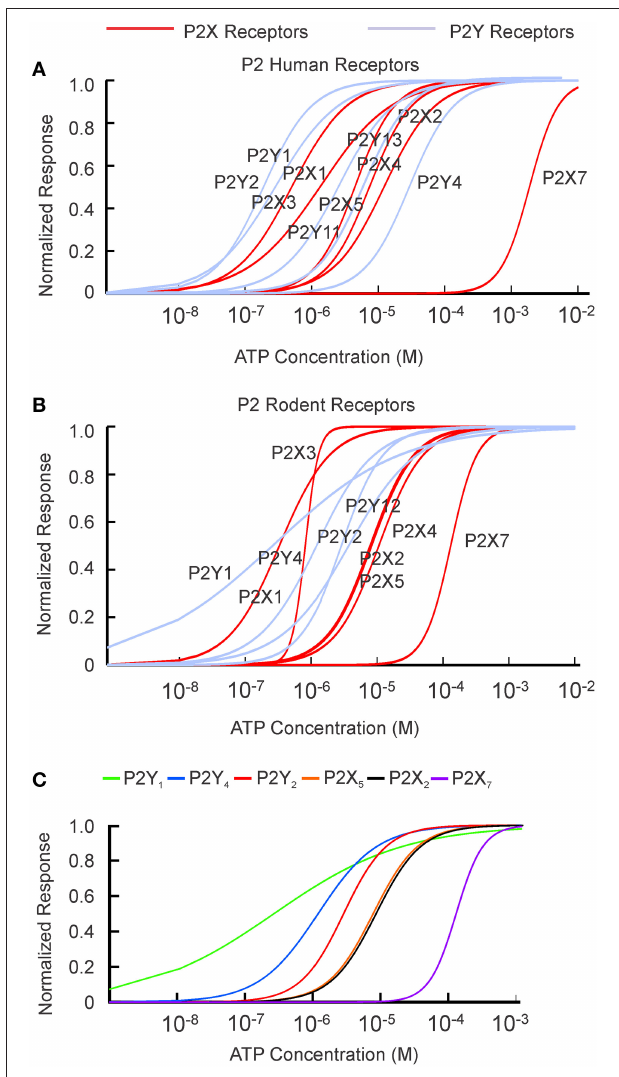
FIGURE 2 | P2 receptors are activated by a wide range of ATP concentrations. ATP concentration dependence obtained from the fitting of published data ( Tables 1 , 2 ) to the Hill equation for P2X receptors (in red) and P2Y receptors (in light purple) were plotted for human (A) and rodent (B) receptors. (C) P2 receptors known to be expressed on